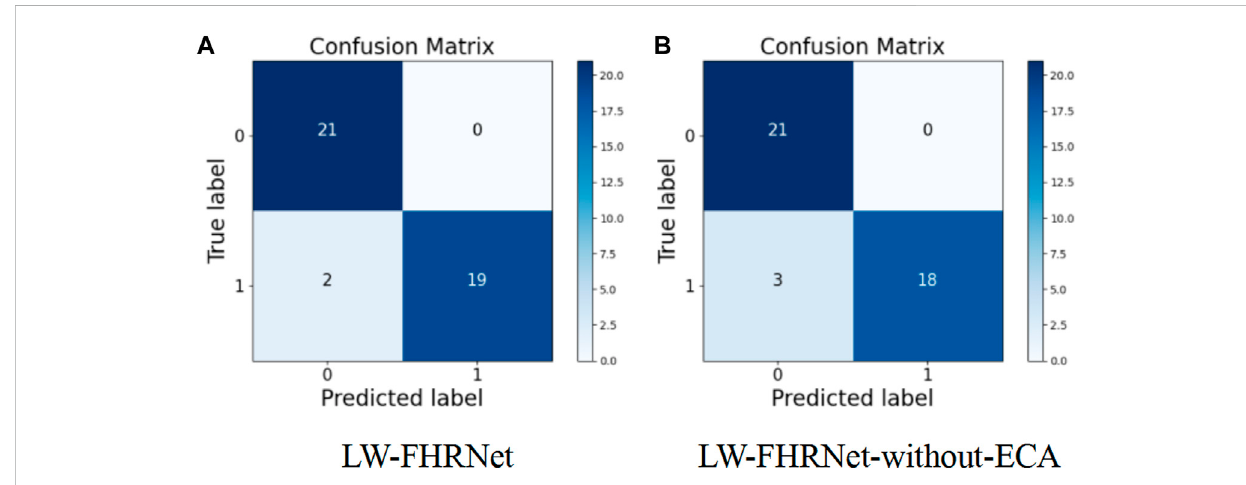
FIGURE 8 Confusion matrix. (A) The proposed LW-FHRNet, (B) the proposed LW-FHRNet without the ECA module.